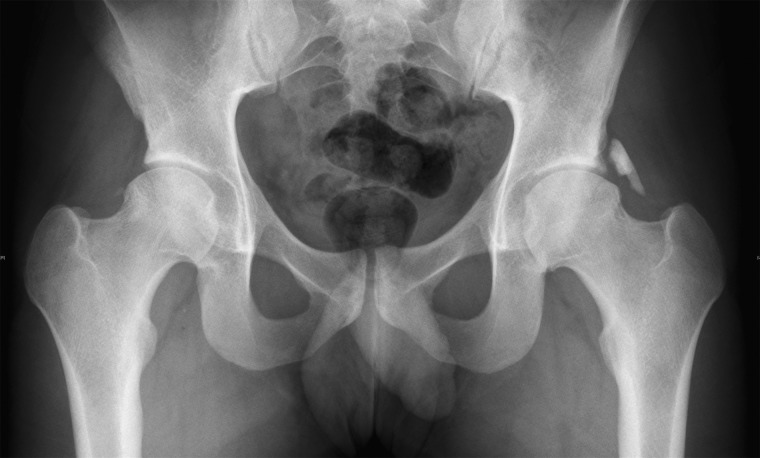
Follow up radiograph of a 20-year-old patient after bilateral hip arthroscopy. The radiograph was taken 9 months status post left and 3 months status post right hip arthroscopy. HO on the left side was evident on radiographs 10 weeks after the index procedure. NSAID prophylaxis using etodolac 600 mg once daily for 2 weeks was administered only after the operation on the right hip.